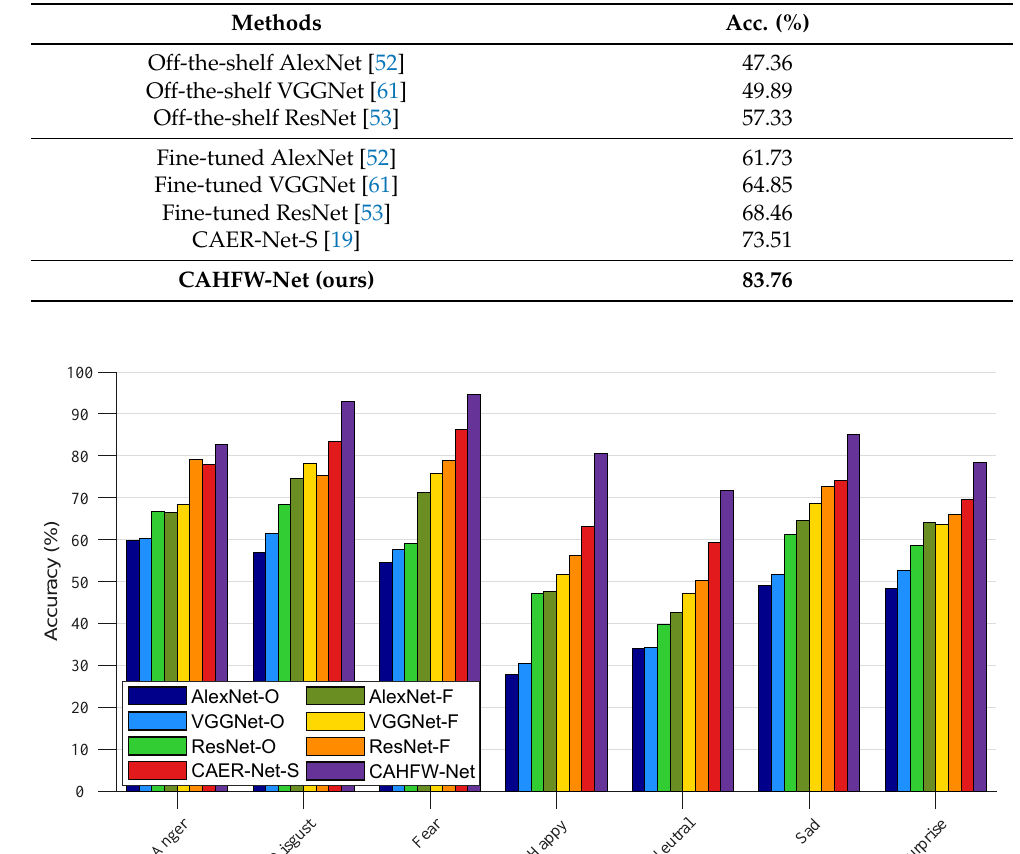
Table 2. Quantitative evaluation of CAHFW-Net in comparison to baseline methods on the test set of the CAER-S benchmark.